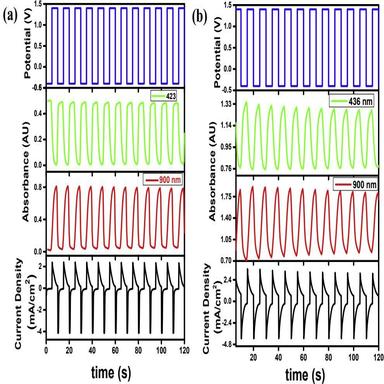
Electrochromic switching, optical absorbance change of a) CH/p(BT) monitored at 900 nm and 423 nm between 0.5 and þ 1.2 V, b) CH/rGO/p(BT) monitored at 900 nm and 436 nm between þ0 and þ 1.5 V in LiClO4/ACN.